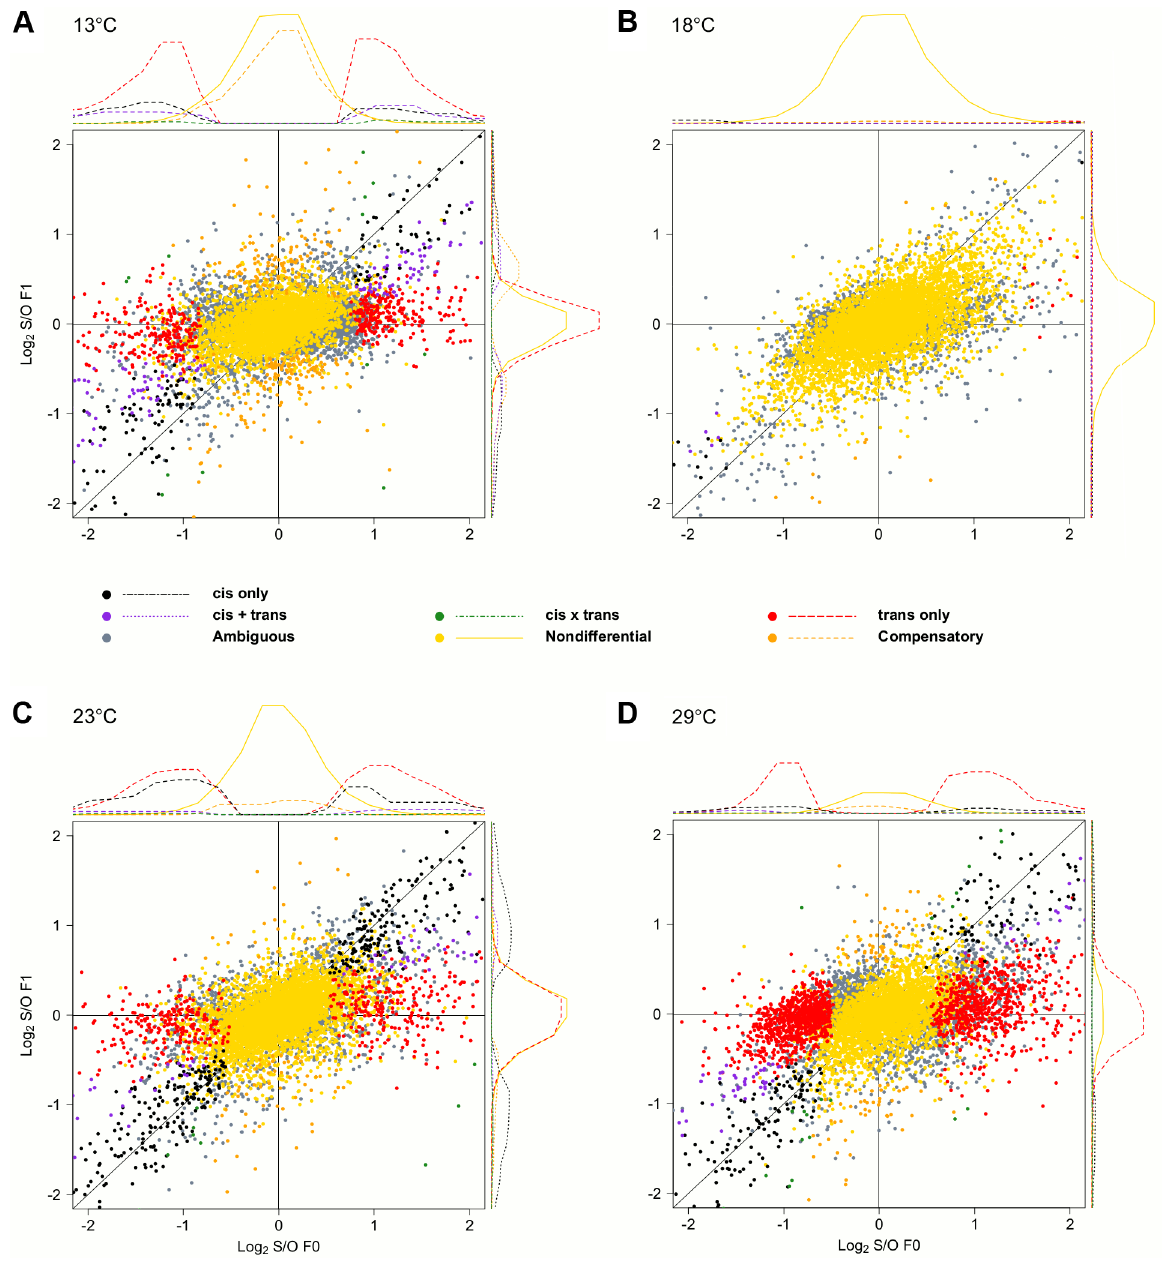
Fig 3. Temperature-dependence of cis - and trans -effects. Scatter plots contrasting the relative allelic expression levels of parents and F1 offspring. Since the large number of genes makes a quantitative assessment difficult, we also show the density distribution for each class of genes. For representation purposes density distribution of genes with no significant differences in gene expression (yellow) is scaled by 1/10. While at (B) 18°C almost no allelic heterogeneity is present, the number of cis - and trans -effects increases with more extreme temperatures, (A) 13°C (C) 23°C and (D)